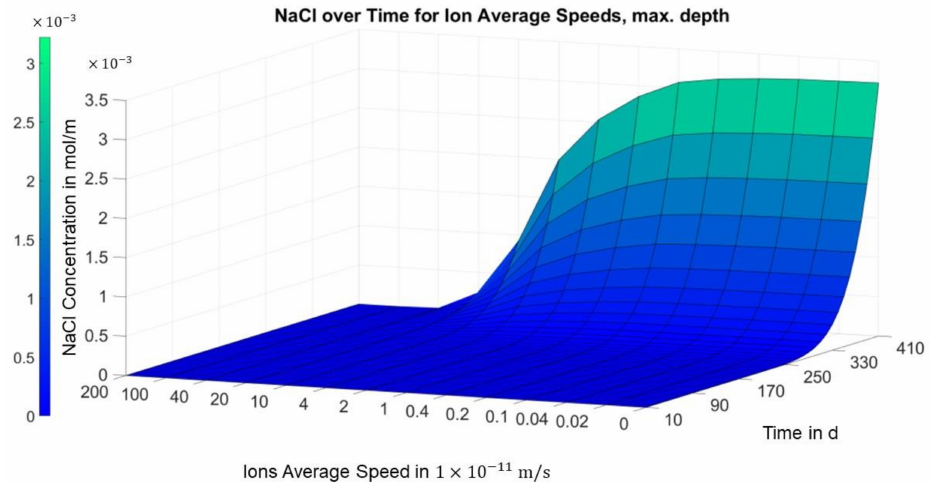
Figure 11. Finite differences solution for concentration over migration speed and time (position = 0.035 m, area III,